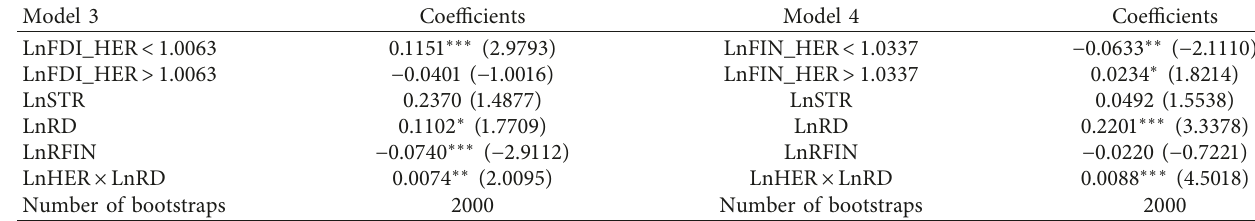
Table 7: Impact of market incentive environmental regulation on the